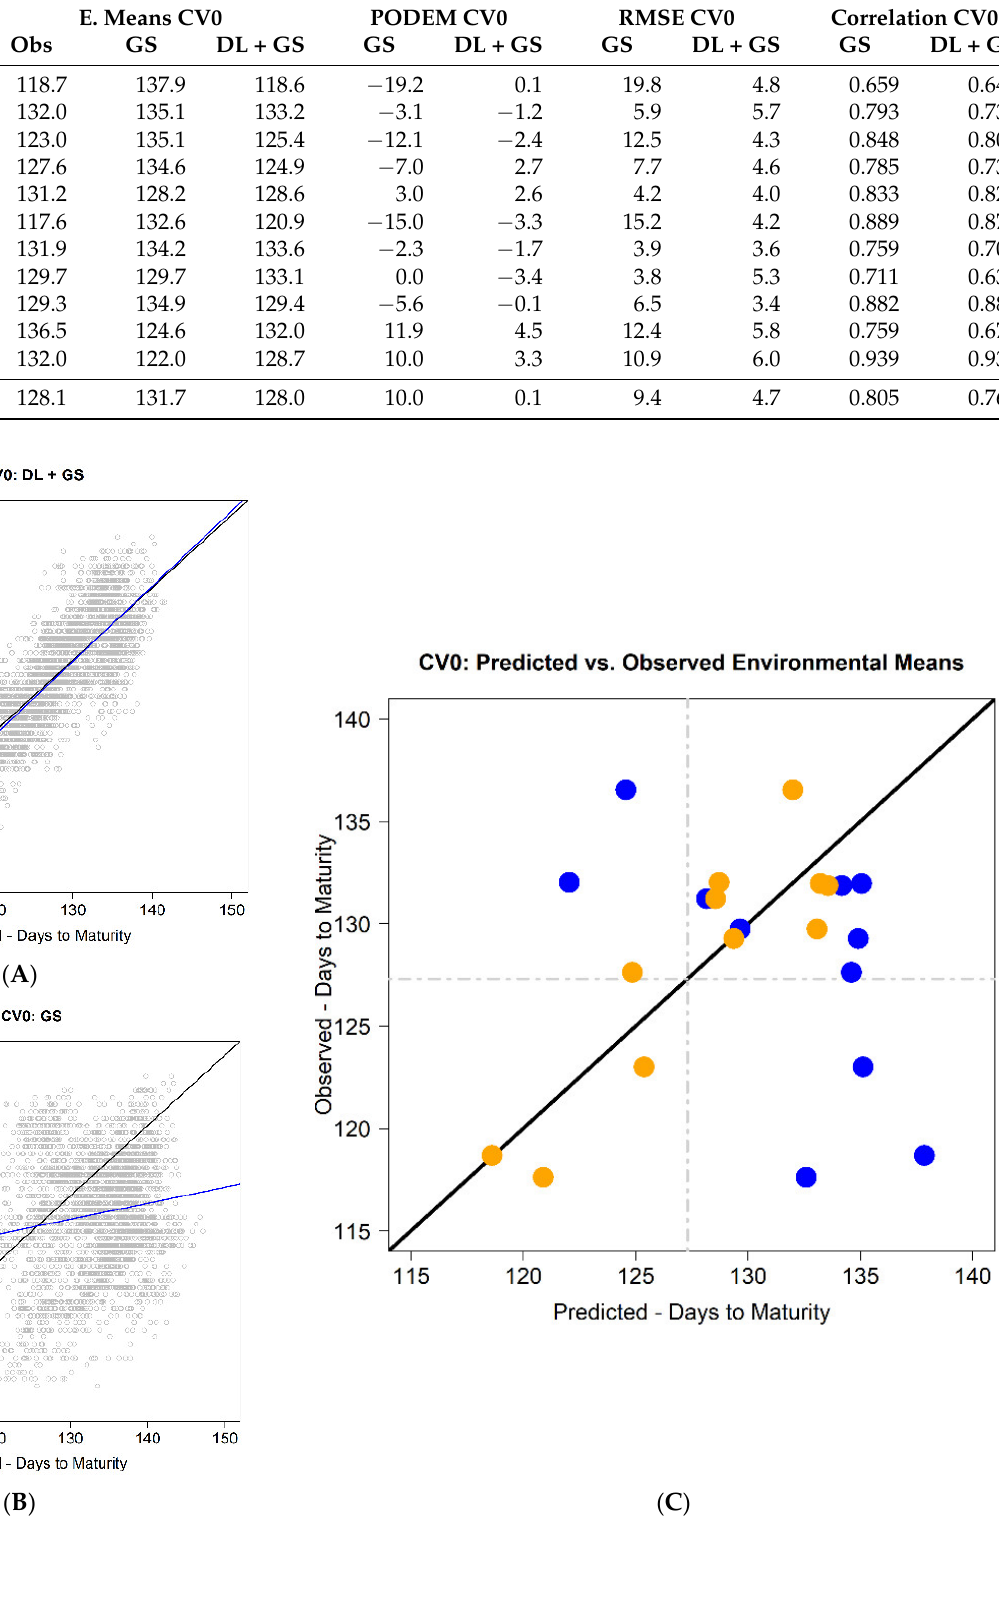
Table 1. Observed and predicted environmental means of days to maturity (DTM) under the CV0 scheme (predicting tested genotypes in unobserved environments) using the conventional GP model and the C-method, along with their corresponding predicted vs. observed difference in the environ- mental means (PODEM), root-mean-square error (RMSE), and Pearson correlations for 367 genotypes observed in 11 environments in the US North-Central Region.